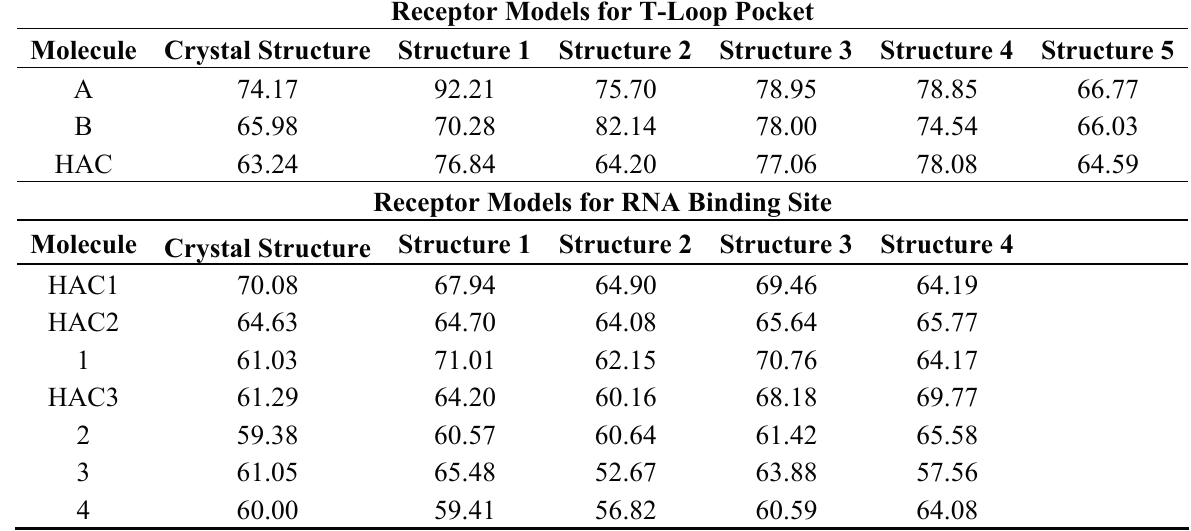
Figure 3. Number of intersection molecules in different number of conformations of the T-loop binding pocket and the RNA binding site of NP at different levels of comparison. ( a ) Number of intersection molecules for the T-loop binding pocket; ( b ) Number of intersection molecules for the RNA binding site. Table 2. Default GOLD docking scores of selected molecules in all receptor